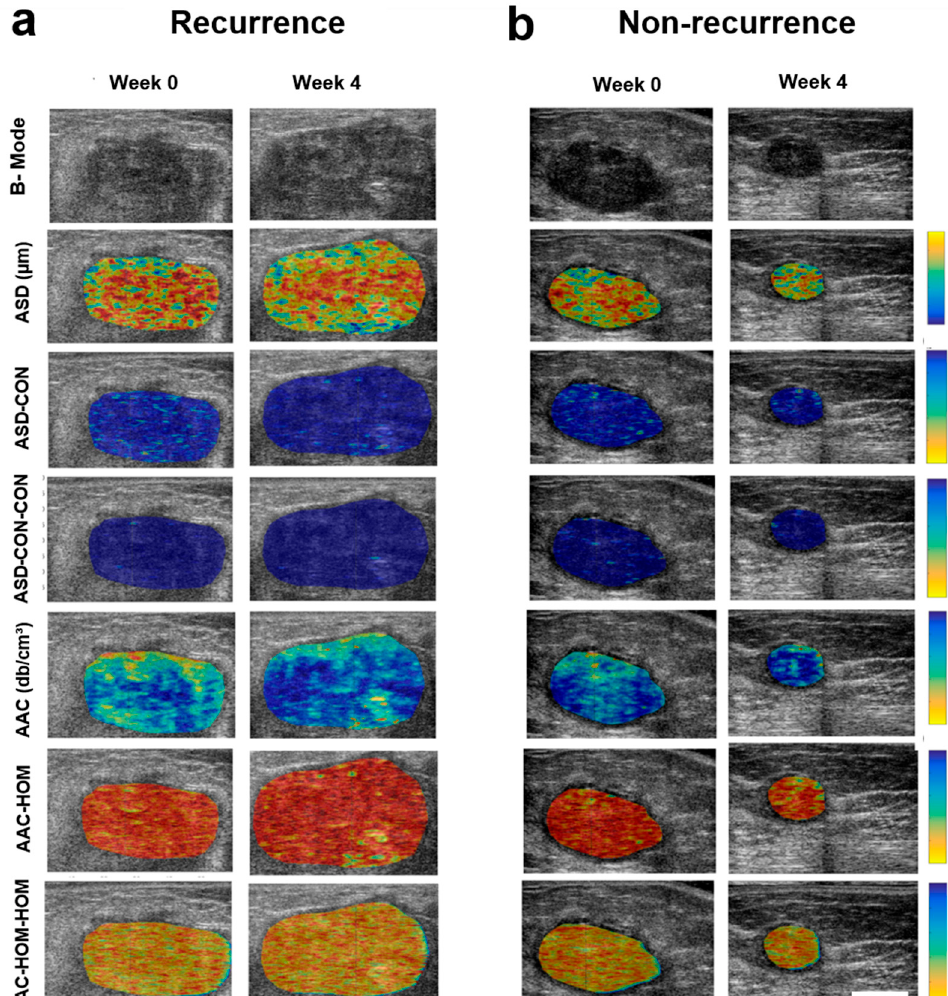
Figure 1. Quantitative ultrasound parametric images for representative patients with and without disease recurrence. Representative ultrasound B-mode images and QUS-derived parametric maps (ASD, ASD-CON, ASD-CON-CON, AAC, AAC-HOM, AAC-HOM-HOM) from one patient each with recurrence ( a ) and no recurrence ( b ) acquired at week 0 and week 4 of treatment. The color maps represent the quantitative values of the spectral parameters within the tumor. The change in values of the parameters with treatment can be appreciated by the change of assigned color to the sub-regions of interest within the tumor. The color scale on the right side represents the range for individual features, ASD parameter of 40 to 200 µ m, ASD-CON texture feature of 0 to 20, ASD-CON-CON texture derivative of 0 to 54, AAC parameter of 7 to 65 db/cm 3 , AAC-HOM texture feature of 0 to 1, AAC-HOM-HOM texture derivative of 0 to 1. The scale bar represents 2